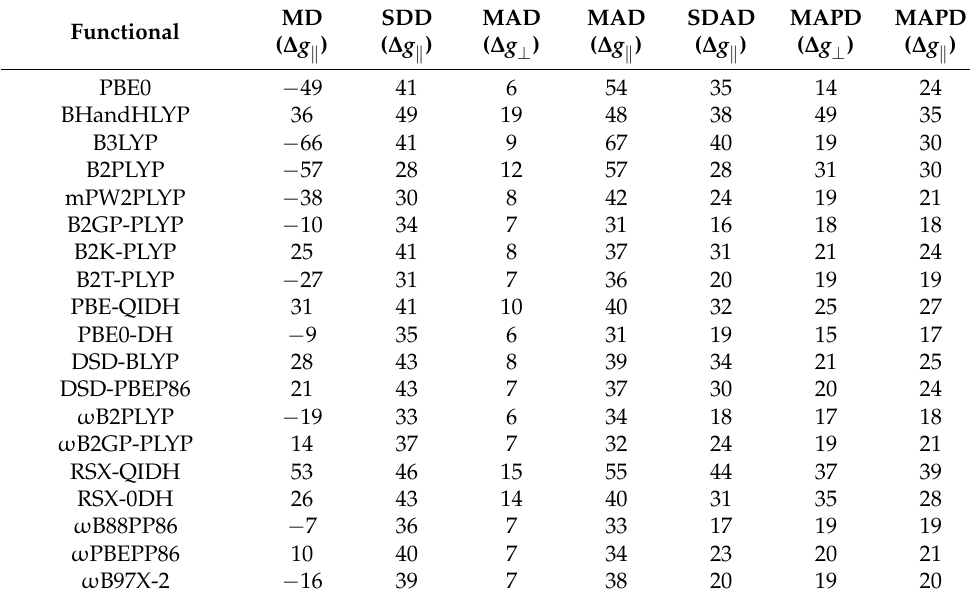
Table 3. Mean difference (MD) and standard deviation of the differences (SDD), mean absolute difference (MAD), standard deviation of the absolute differences (SDAD) and mean absolute per- cent difference (MAPD), from the experimental values of the parallel and perpendicular g -shifts components calculated with each functional. Values are expressed in